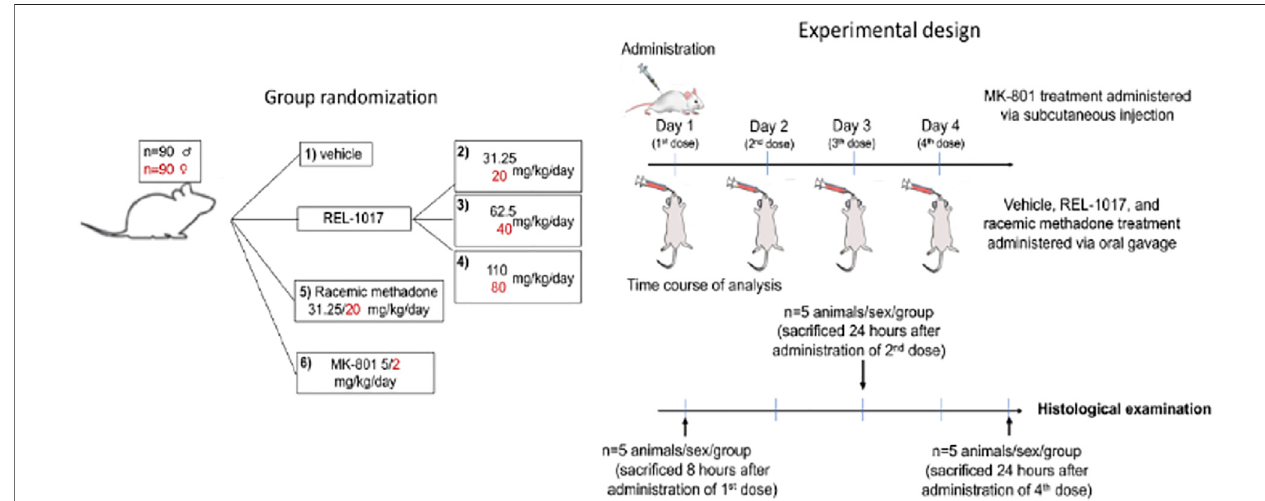
FIGURE1| Study design. Thevehiclecontrol, REL-1017, and methadone racemate wereadministered oncedaily for4 days duringthe study via oralgavage. The doselevelsformaleratsreceivingtheREL-1017were31.25,62.5,and110 mg/kg/day.Femaleratsreceived20,40,and80 mg/kg/day.Thedosevolumeforallgroups was 5 ml/kg. The groups receiving the vehicle control or methadone racemate were administered in the same manner as the REL-1017 at a dose level of 0 (vehicle control),31.25(males),or 20(females)mg/kg/day.Thepositivecontrolwasadministered onceon Day1 via subcutaneousinjection at adose levelof5(males) or2 (females) mg/kg at a dose volume of 1 ml/kg. Clinical evaluation was performed daily. The presence of neuronal vacuoles (Olney ’ s effect) was analyzed by light microscopy in H & E stained brain tissue (2 um thick), on brains obtained 8 h after the administration of the fi rst dose of drugs. Neuronal necrosis and microgliosis were assessed by histological examinations in brains collected 24 h after the administration of the second dose (Day 3 of the study) and 24 h after the administration of the fourth dose (Day 5 of the study).